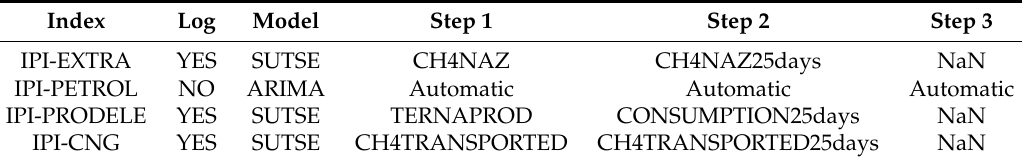
Table A1. Synthesis of state–space models used for energy.